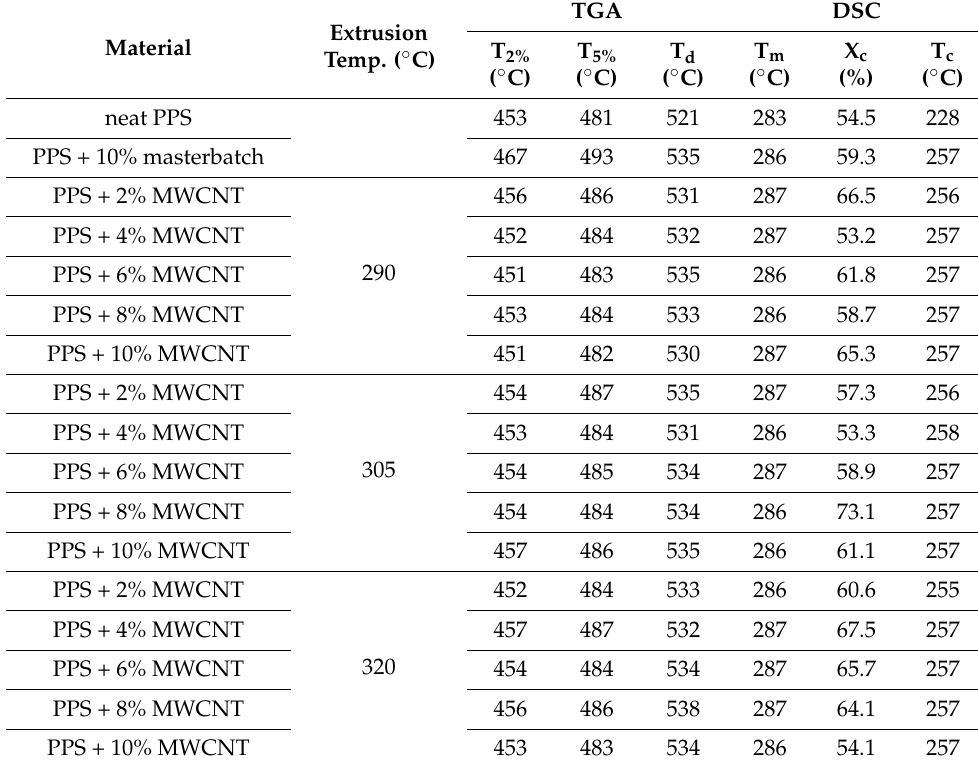
Table 1. The results of the thermal